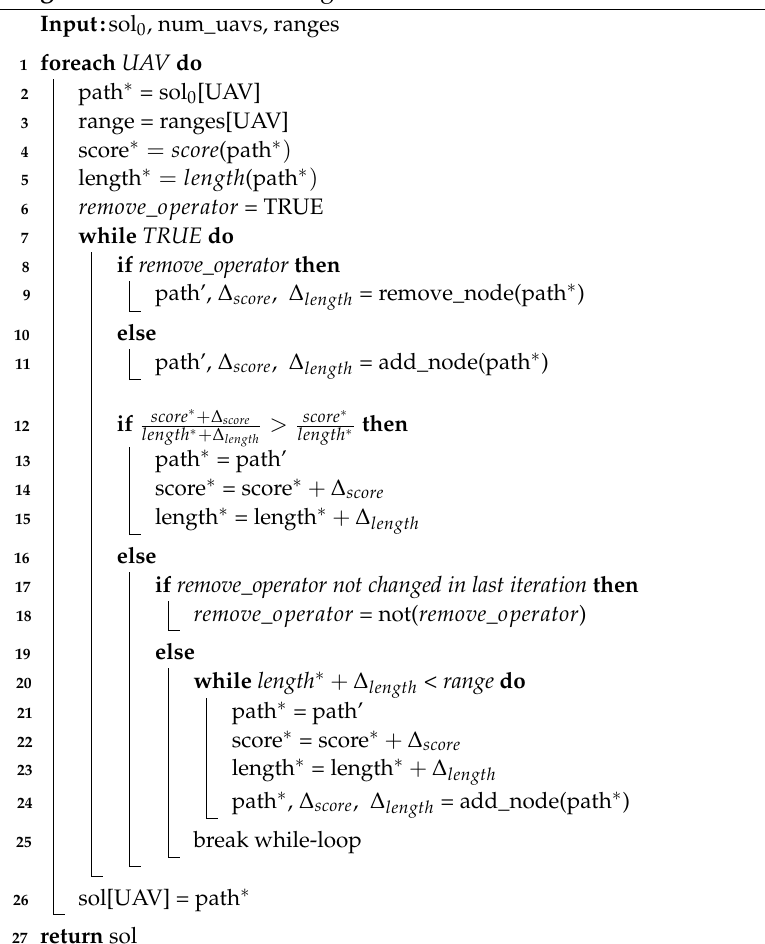
Algorithm A2: Hill